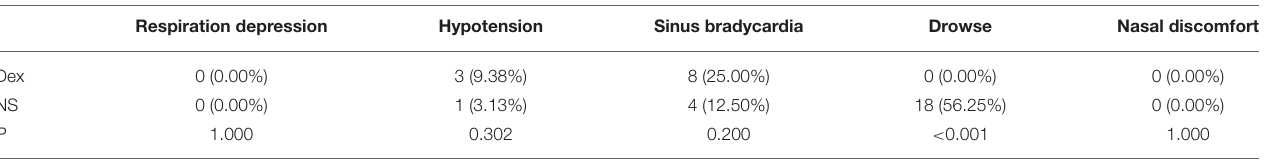
TABLE 4 | Comparison of other adverse reactions in two groups (cases, %). Respiration depression Hypotension Sinus bradycardia Drowse Nasal